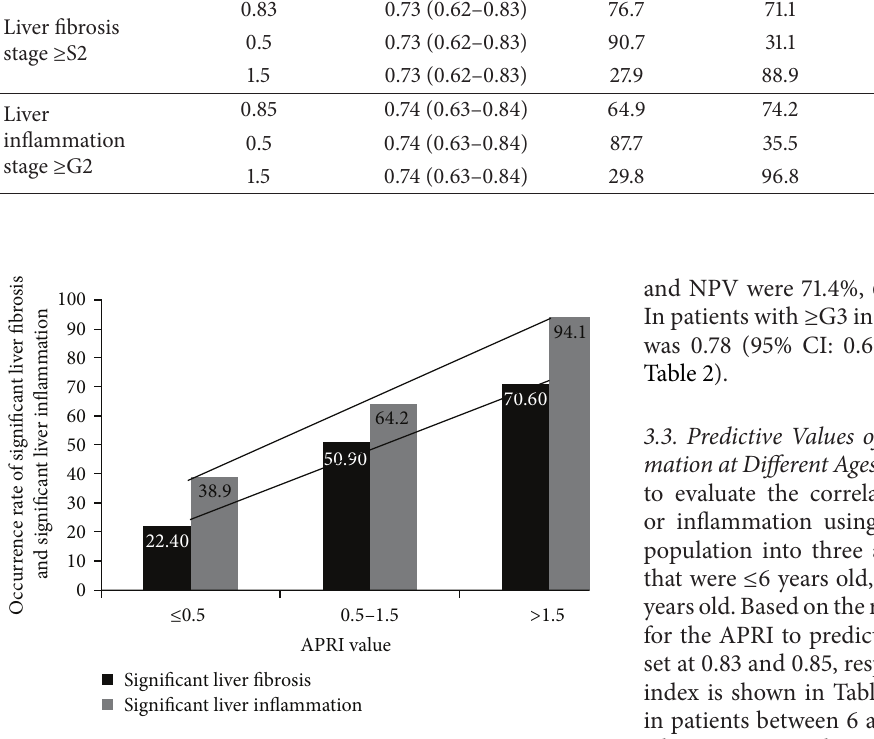
Figure 1: The percentage of significant liver fibrosis and significant liver inflammation in different groups with differential APRI